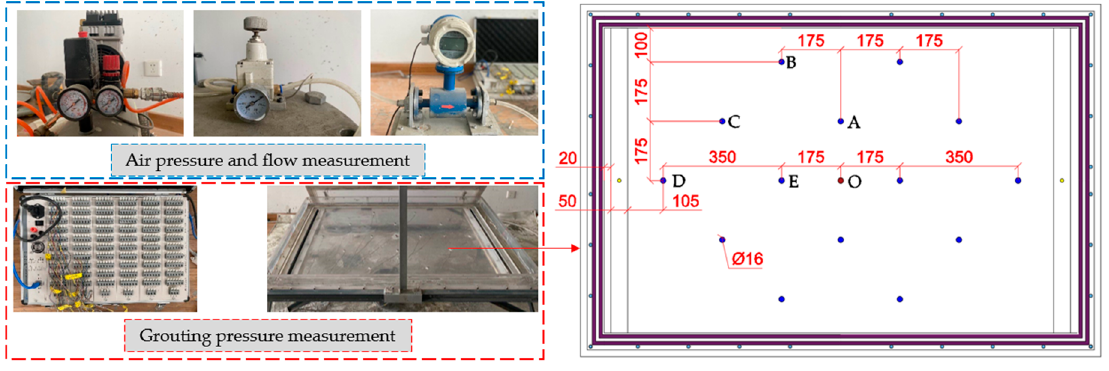
Figure 7. Measurement system and pressure sensors’ distribution.